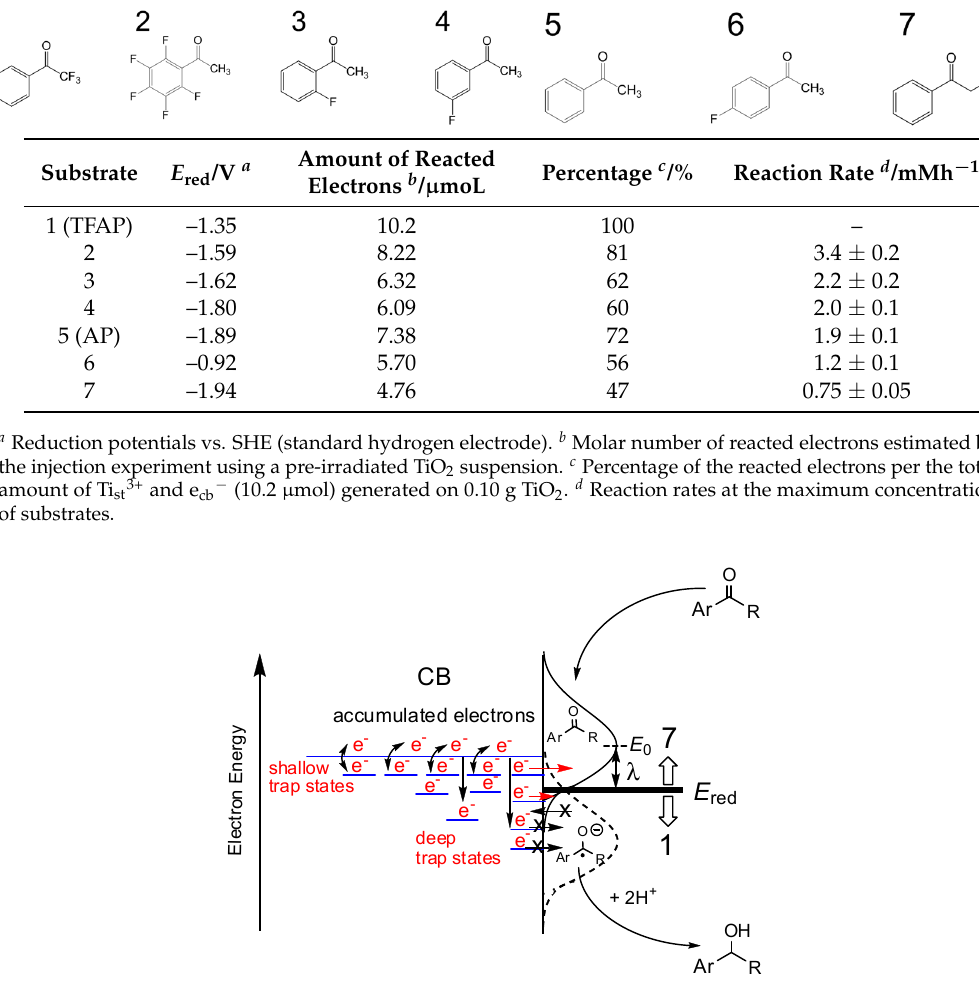
Amount of Reacted